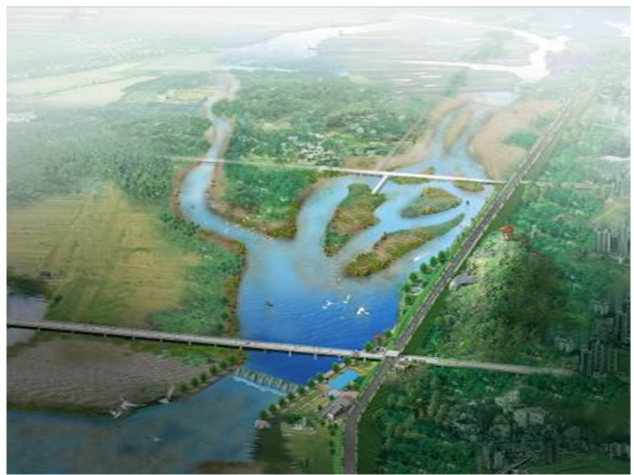
Figure 15. Wetland restoration projects.